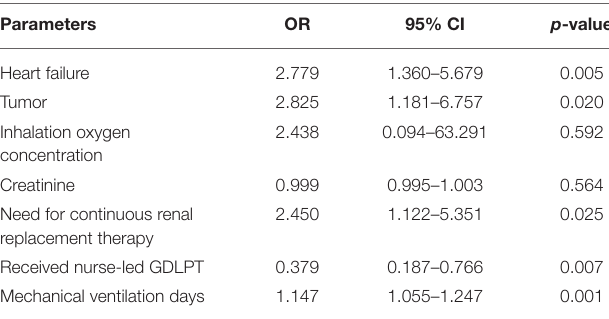
TABLE 3 | Multivariate logistic regression analysis for predicting 28 day mortality in older patients with sepsis and pneumonia.